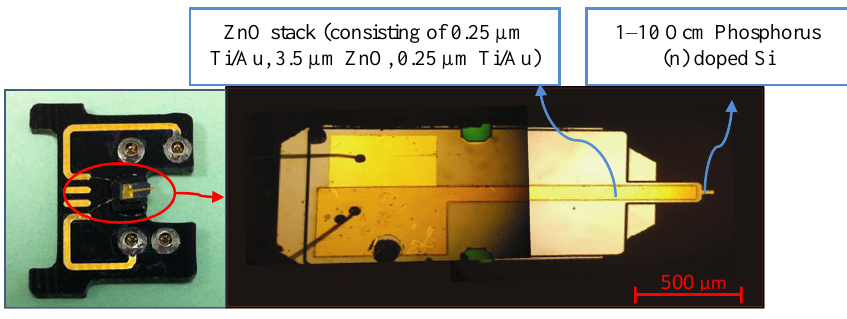
Figure 1. Veeco Active Probe with ZnO self-sensing layer deposited on the